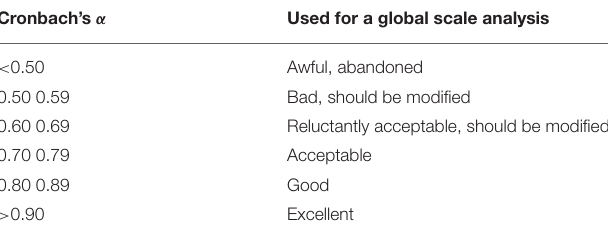
TABLE 3 | Evaluation principles for Cronbach’s α .